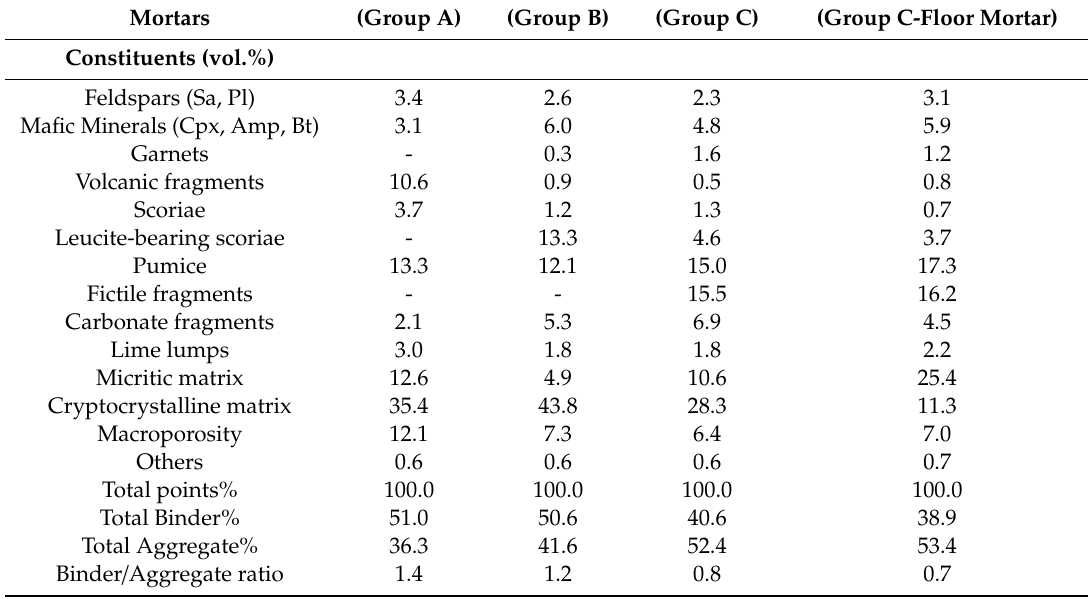
Table 2. Petrographic features of the samples and their microscopic modal analysis—mineral abbreviations from Whitney and Evans